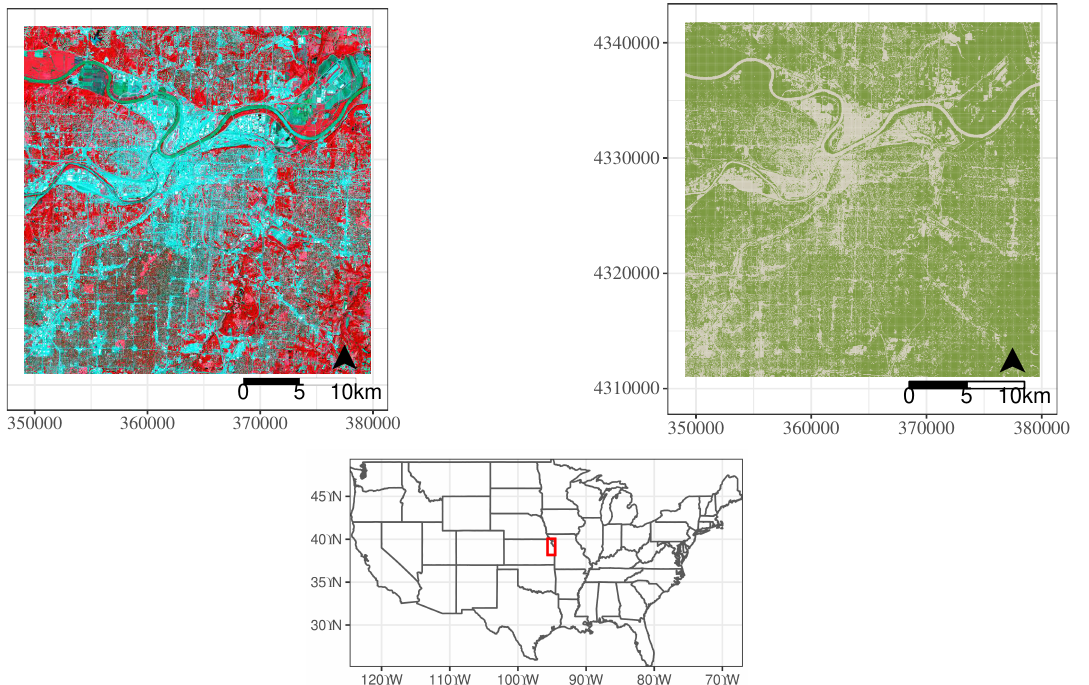
Figure 1. The Kansas City metropolitan area (left)—shown as a false color composite Landsat image from 6 June 2011—exhibits characteristic patterns of urban sprawl. The spatial distribution of green space (right) with green pixels representing green space and grey pixels representing all non-vegetated surfaces. The location of Kansas City within the U.S. is also